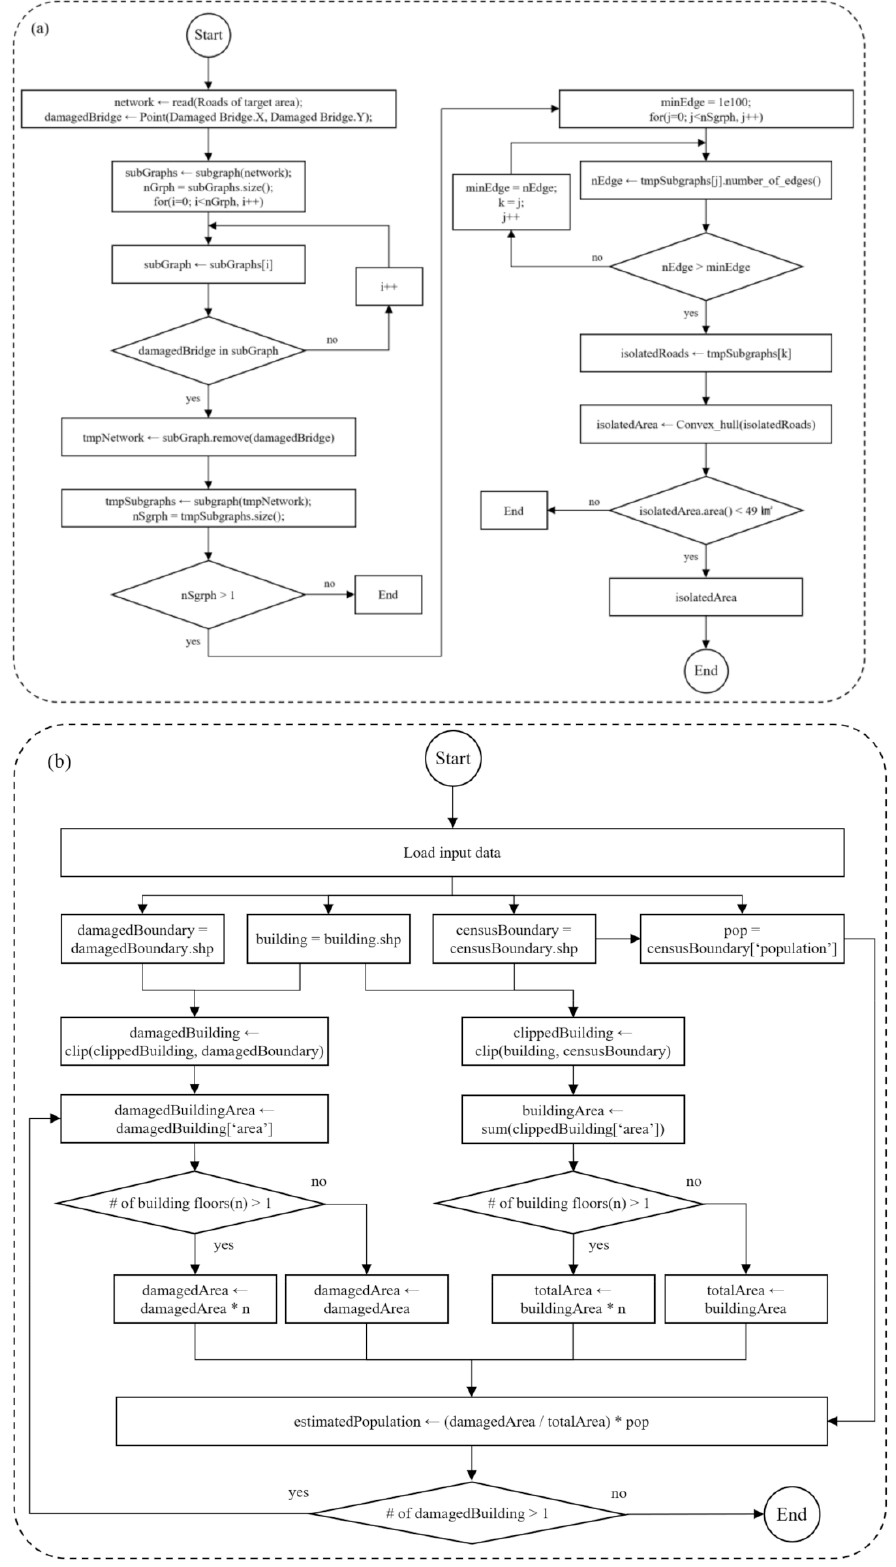
Figure 5. Diagrams showing the two Python scripts programmed to detect ( a ) the boundary of the isolated area and ( b ) the buildings and population in the isolated